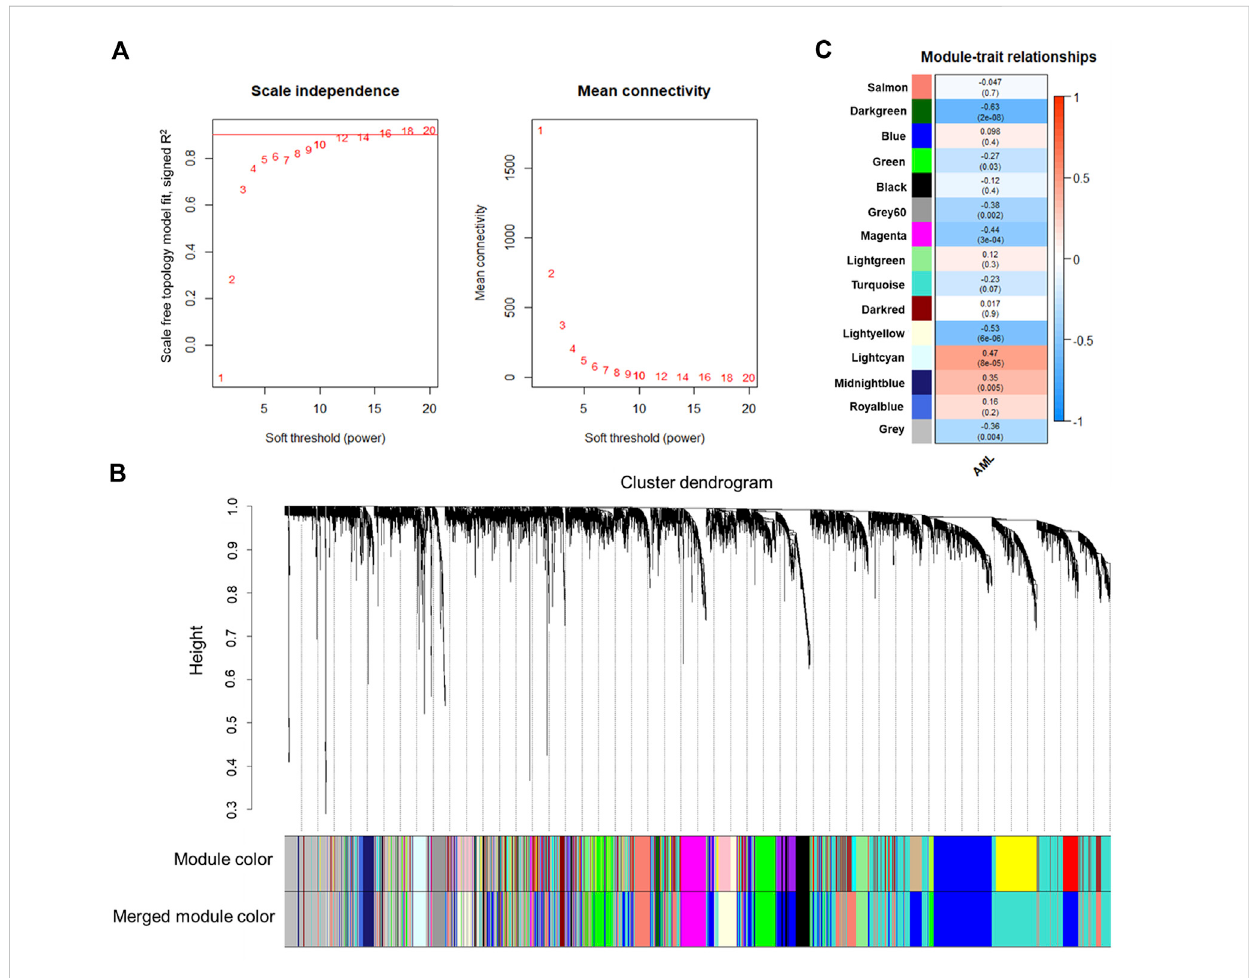
FIGURE 1 WGCNA analysis of the human AML expression data. (A) Soft-thresholding index R 2 or mean connectivity ( y-axis ) as a function of different β thresholds ( x-axis ). A β of 12 was selected for constructing the network (indicated by a red line in the plot). (B) Gene dendrogram obtained by clustering the dissimilarity based on consensus Topological Overlap. The color rows show the preliminary (module color) and the merged module assignments (merged module color). A total of 23 preliminary modules were detected by clustering 6,200 genes. Merging the moduleswith adistance threshold of 0.25 resulted in 15 modules. (C) Correlation between module eigengenes and the clinical trait of the samples (presence or absence of the disease). Associations with a p < 0.05 were considered signi fi cant. The numbers in the heatmap represent the correlations of the corresponding module eigengenes and clinical trait, with p -values shown in parentheses. The color intensity indicates the